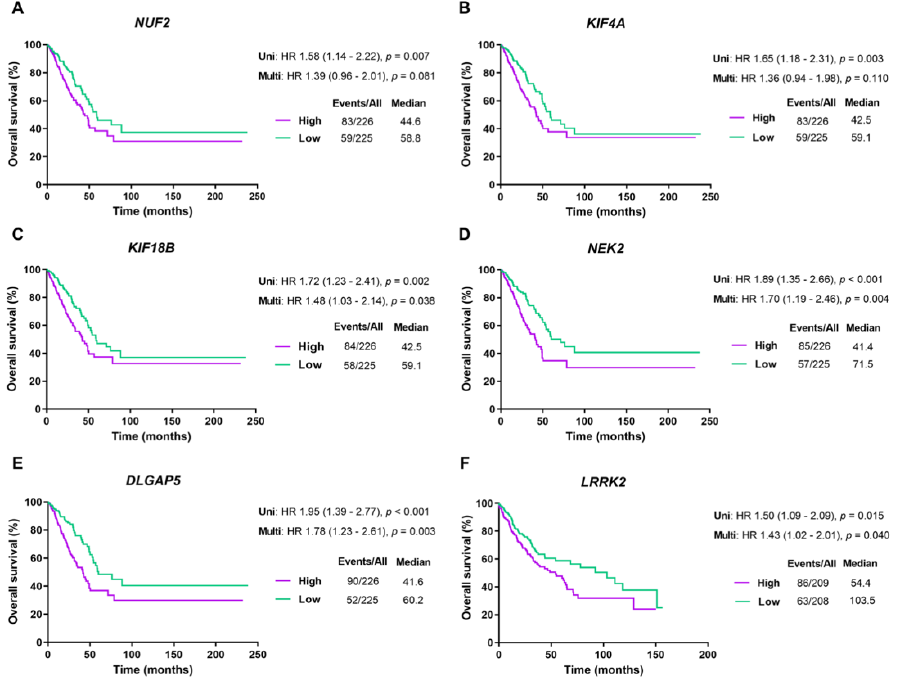
Figure 5. Survival analysis of the top five DEMGs in LUAD and LUSC patients. Kaplan–Meier curves present the overall survival rate of NUF2 ( A ), KIF4A ( B ), KIF18B ( C ), NEK2 ( D ), and DLGAP5 ( E ) in LUAD, and LRRK2 ( F ) in LUSC. Abbreviations are as follows: Uni, univariate analysis; Multi, multivariate analysis; HR, hazard ratio; Events/All, No. of events/No. of patients; Median (months).